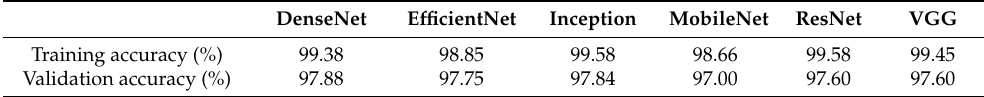
Table 7. Classification results for training and validation